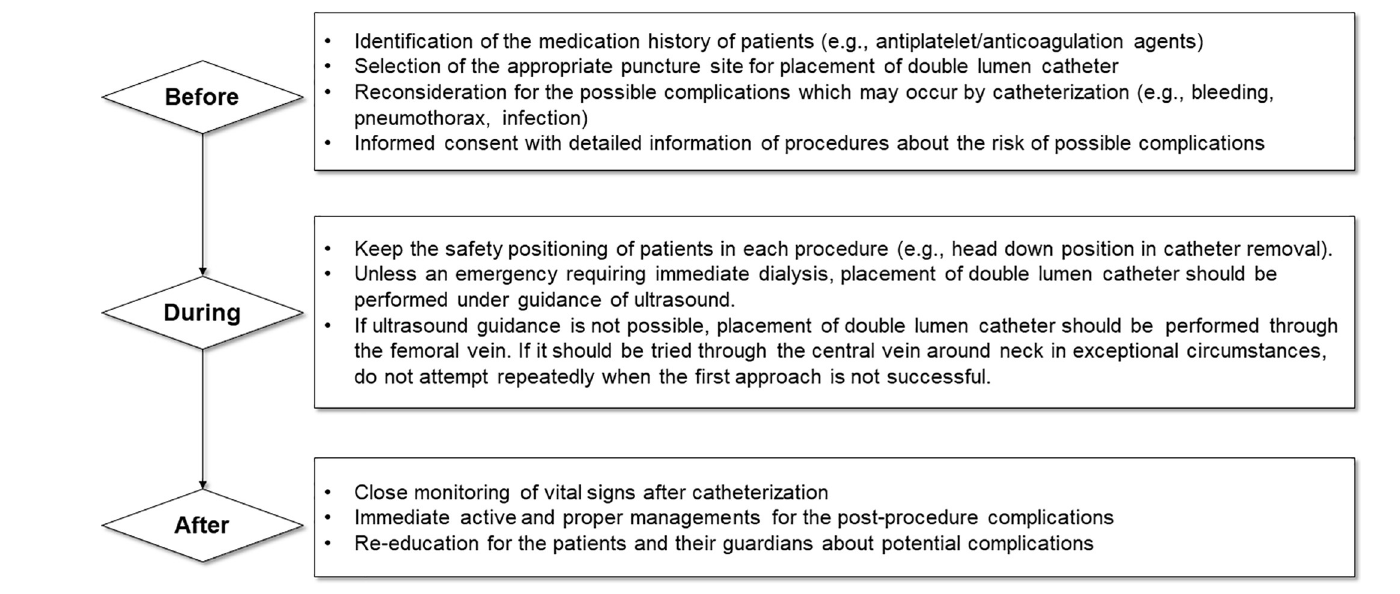
S1 Table. Judicial characteristics of the litigation cases. S2 Table. Detailed summary of dismissed fourteen-cases concerning hemodialysis lawsuits. (DOCX) S3 Table. Number of hemodialysis patients and sessions and total cost of hemodialysis in Korea over the past five years.